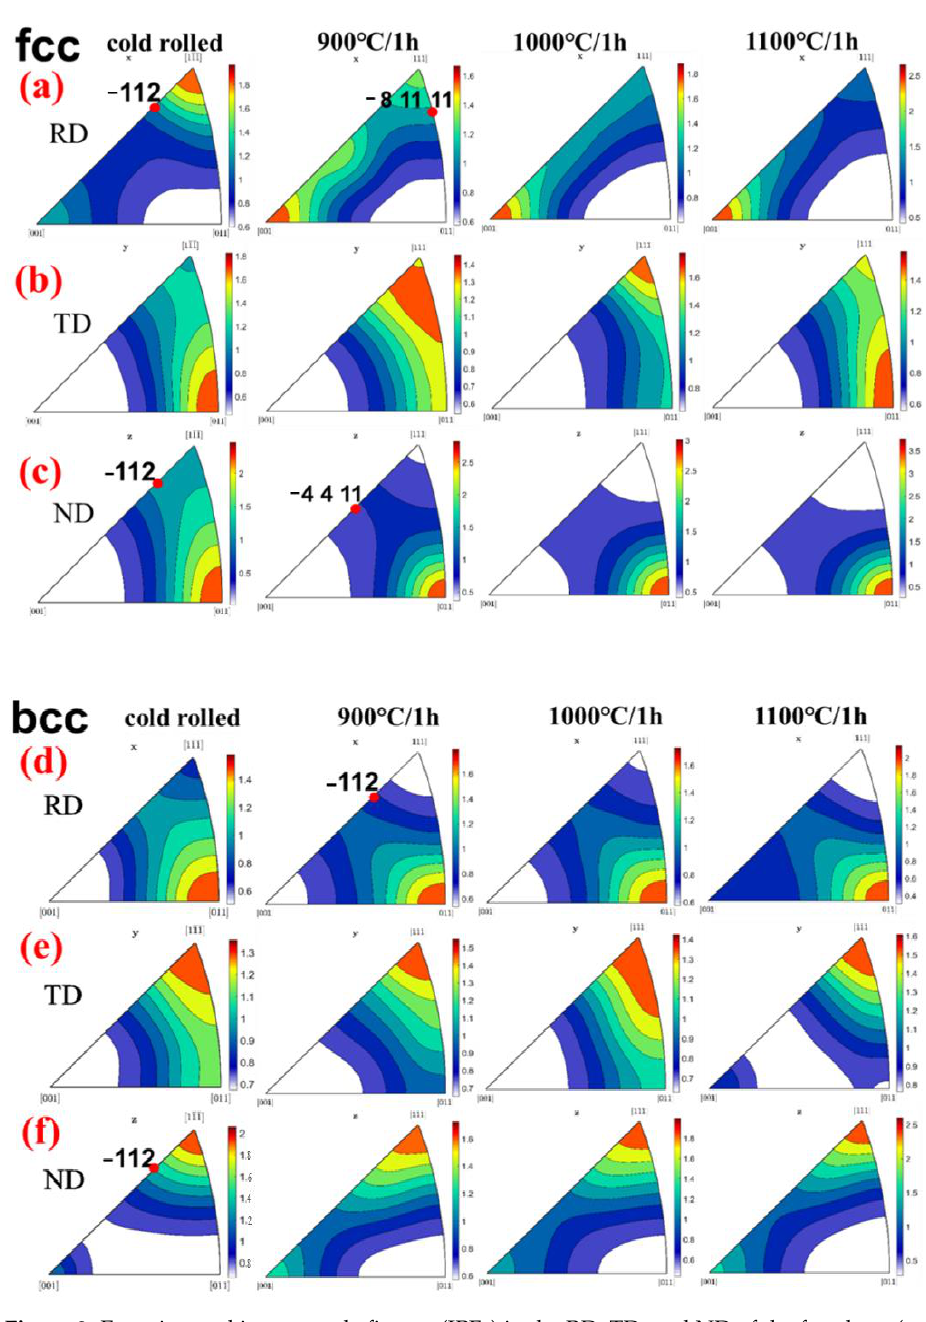
Figure 2. Experimental inverse pole figures (IPFs) in the RD, TD, and ND of the fcc phase ( a – c ) and bcc phase ( d – f ), at an annealing temperature of 900 °C/1 h~1100 °C/1 h. All texture components in different positions can be detected from the